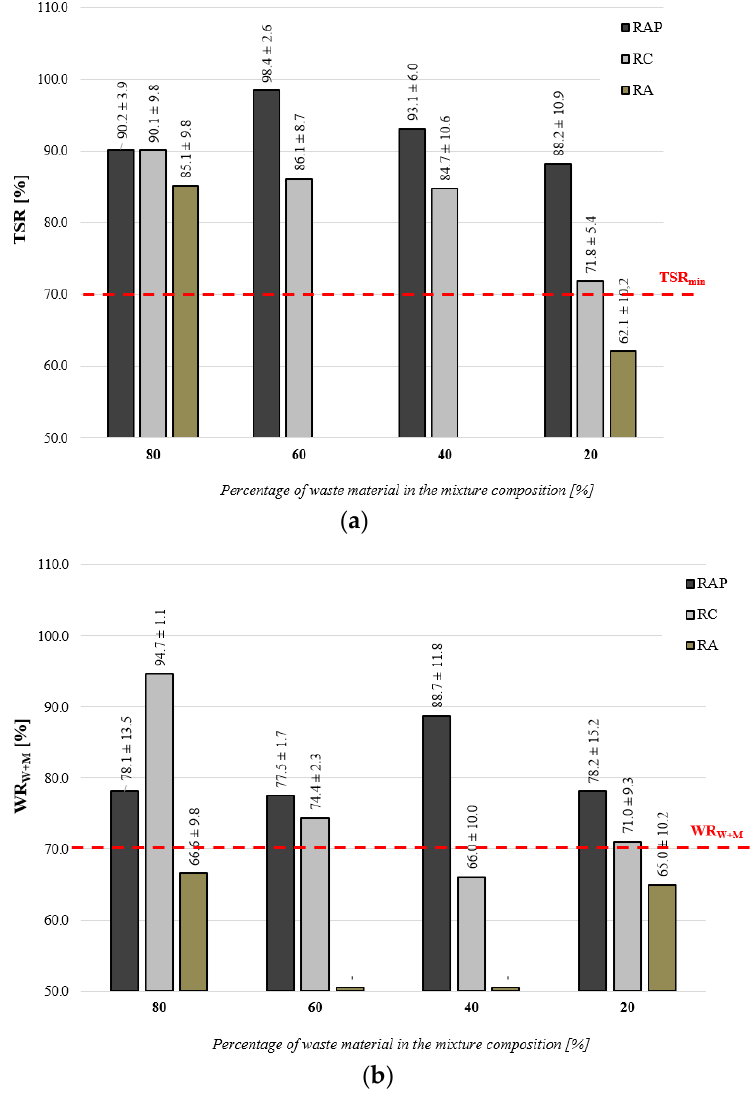
Figure 7. Resistance to water and to water and frost: ( a ) TSR index, ( b ) WR W+M index.